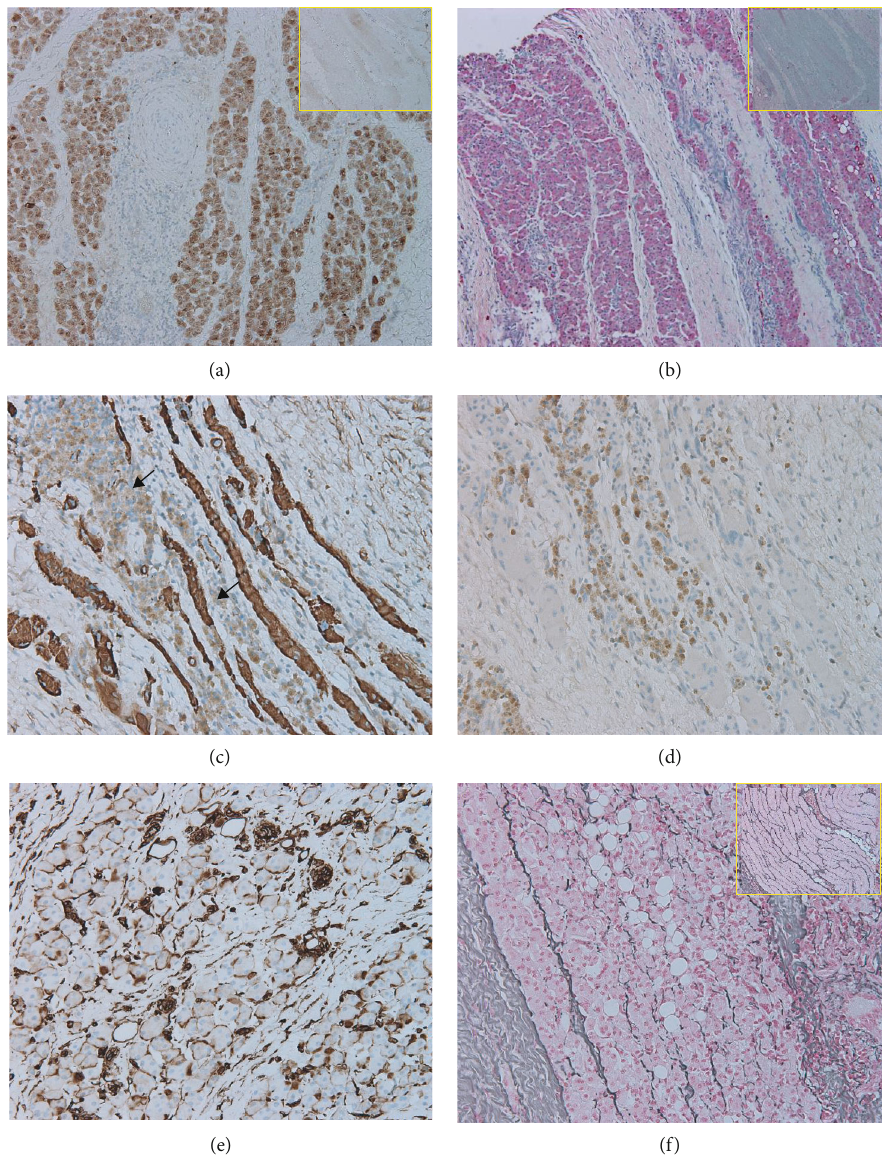
Figure 2: The immunohistochemical property of the cell groups is demonstrated: (a) CD56 is strongly positive, and there is progressive loss of CD56 in the di ff erentiated muscle cells (inbox); (b) S100 detected with red chromogen which is strongly expressed in those small cell groups, and progressive loss of S100 is noted in the di ff erentiated skeletal muscle (inbox); (c) actin is mildly positive in those cells (arrows) and strongly positive in nearby intermediate to well-di ff erentiated muscle cells; (d) myogenin shows few cytoplasmic positivity to negative stain; (e) no strong cytoplasmic positivity is noted with vimentin; (f) reticulin stain shows no pericellular stain which is evident in well-di ff erentiated skeletal muscle